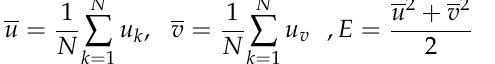
Figure 16. Seawater density difference on 1 January 2008 at 03:00 a.m.